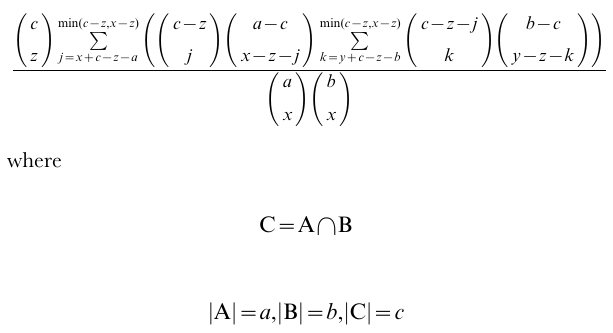
Figure S1 Probability mass for the frequency of annotations at different levels of the MP in the amalgamated list of gene- phenotype associations from MGI and Europhenome and the three GOs in Ensembl. Figure S2 Details of example gene communities: A) Community 2 in the MP level 5 gene network. This community visually corresponds to the community that is frequently annotated with the granularity level 1 MP term ‘‘hearing/vestibular/ear pheno- type’’ [MP:0005377] and is highly enriched in the GO terms ‘‘mechanoreceptor differentiation’’ [GO:0042490] and ‘‘sensory perception’’ [GO:0007600]. B) Community 5 in the MP level 8 gene network. This community visually corresponds to the community that is frequently annotated with the granularity level